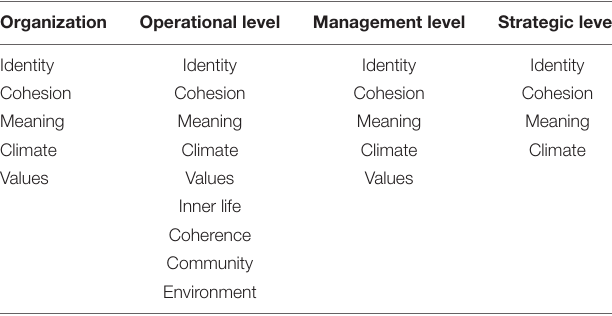
TABLE 4 | Attractive factors for the organization and its levels. TABLE 5 | One-dimensional factors for the organization and its